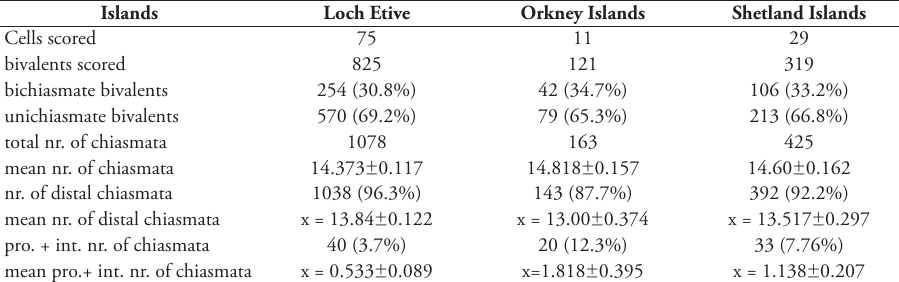
Table 1. Number of each class of chiasma and mean values per cell in Scottish individuals of Chrysolina latecincta ssp. intermedia . pro. = proximal, int. = interstitial, nr. =